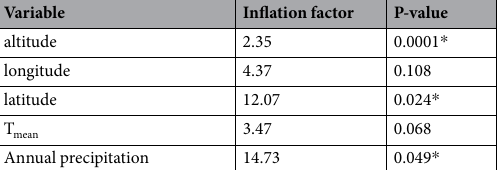
4 Scientific RepoRts | 7: 5395 | DOI:10.1038/s41598-017-05731-0